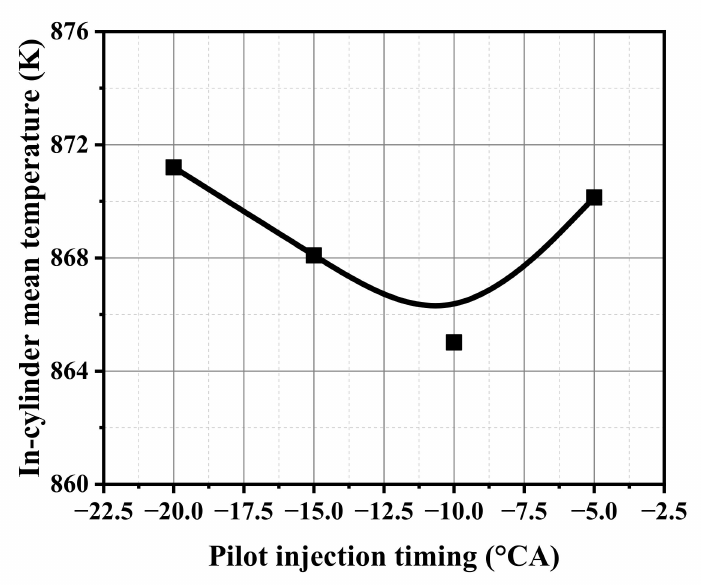
Figure 19. In-cylinder mean temperature of different pilot injection timings at the beginning of ex- haust.